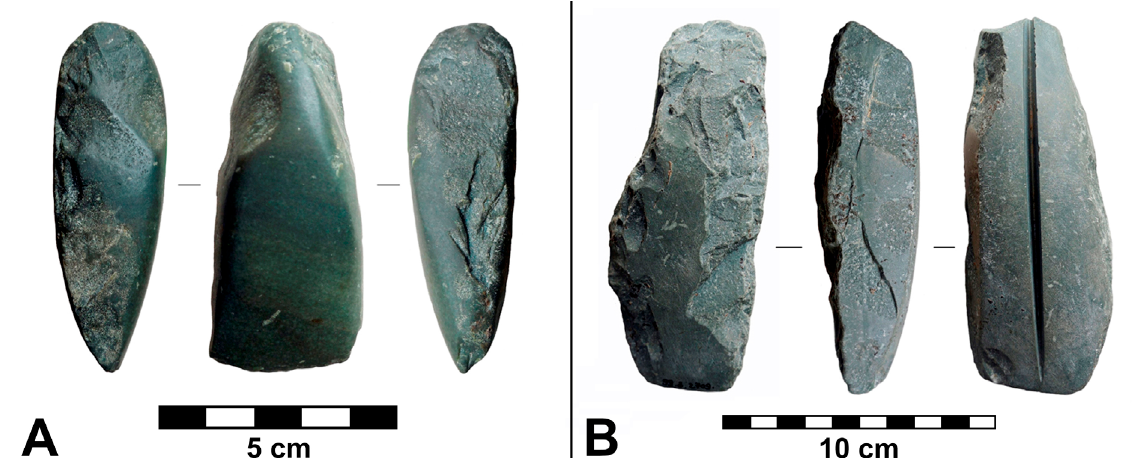
Figure 3. Hódmezővásárhely -Gorzsa, late Neolithic, Tisza Culture. A: adze blade knapped before polishing, hornfels (GOR-489); B: polished axe blade knapped after polishing and trace of “ débitage par sciage ” (Nougier & Romain 1953), reworking attempt, hornfels (GOR-606).